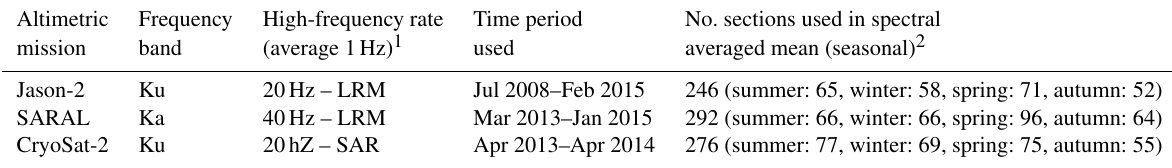
Table 1. Altimetric data used in this study. Altimetric Frequency High-frequency rate Time period No. sections used in spectral mission band (average 1Hz) 1 used averaged mean (seasonal) 2 Jason-2 Ku 20Hz – LRM SARAL Ka 40Hz – LRM CryoSat-2 Ku LRM: conventional low-resolution mode; SAR: synthetic aperture radar mode. First number corresponds to the total number of 200km sections used in the regionally averaged spectra (Fig. 3); numbers in brackets correspond to the number of sections used in each seasonal average (Fig. 4).